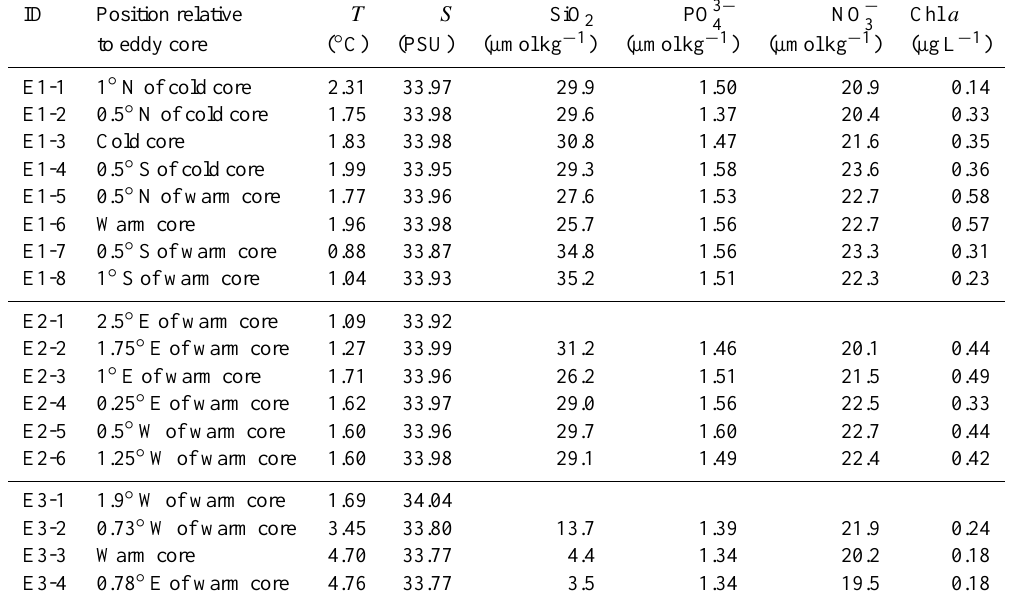
Table 2. Average upper ocean (surface to 100m depth) physical and chemical water column characteristics, obtained from CTD profiles, in and around warm and cold eddies. Samples for nutrient and chlorophyll a analysis were not collected at CTD stations E2-1 and